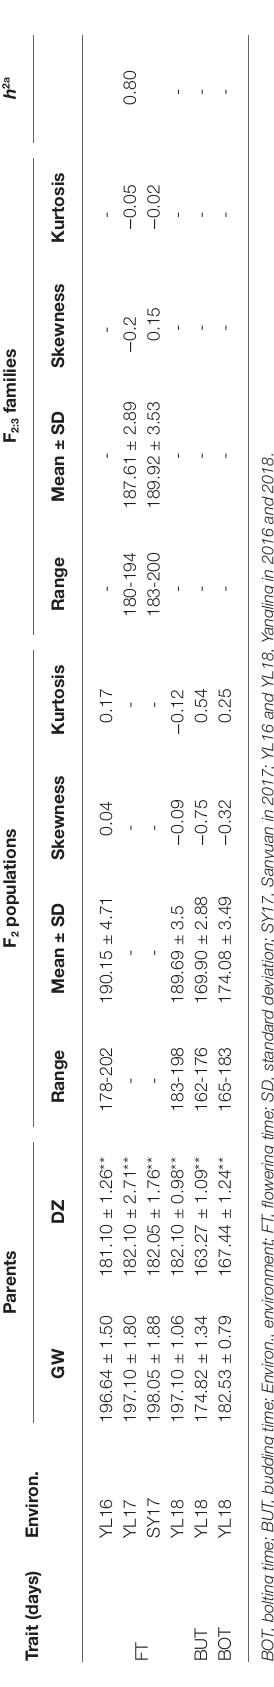
A10, and C05, with an LOD value ranging from 2.94 to 4.57 ( Table 2 ). Individual QTL explained 3.74–12.28% of the phenotypic variation (PV). Among these, qFTYL16-5 and qFTSY17-7 located on C05 and A10 accounted for 12.28 and 12.17% of the total PV, respectively. qFTYL16-16 had positive